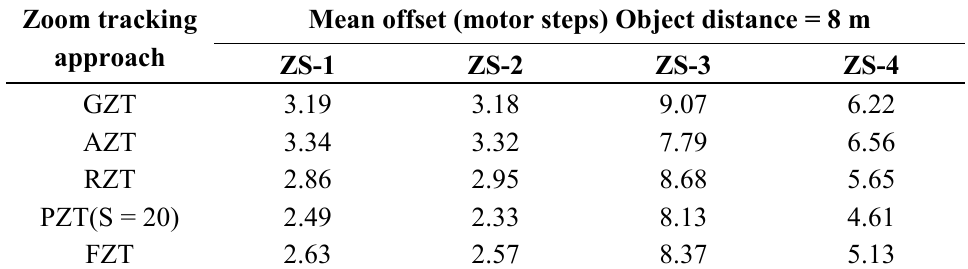
Table 2. Tracking accuracy for each zooming sequence.